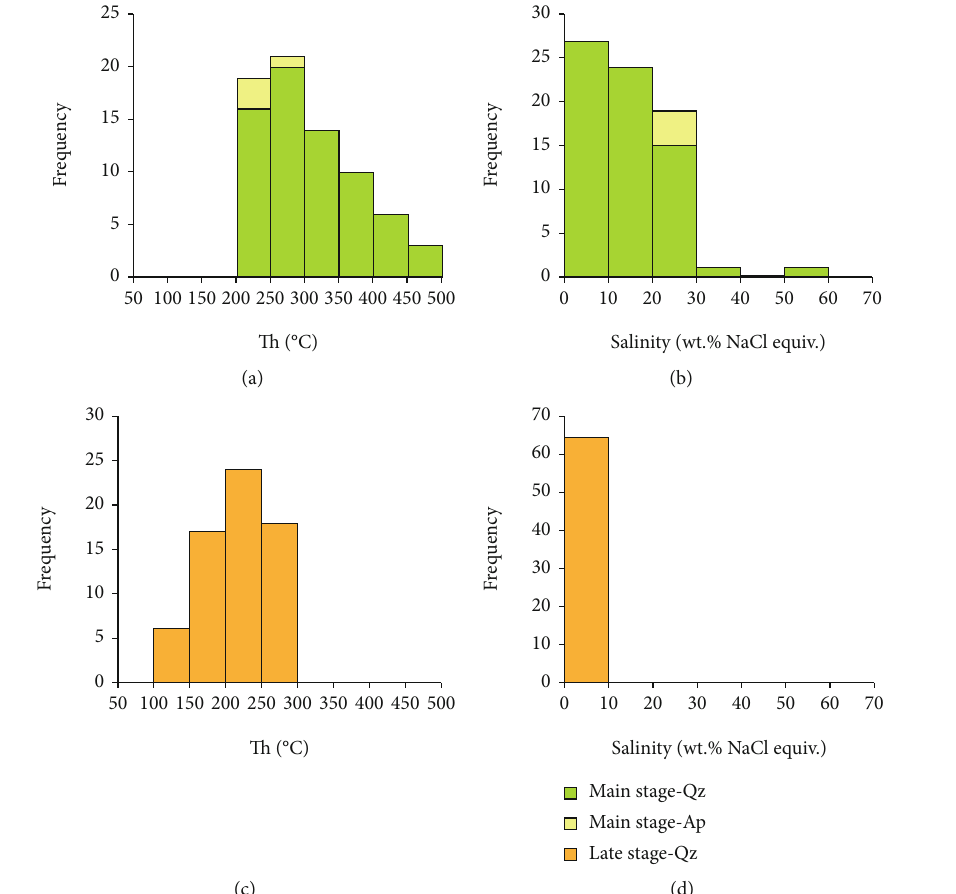
fl uid inclusions in the main ore stage (a, b) and the late stage (c, h ) and salinitites of